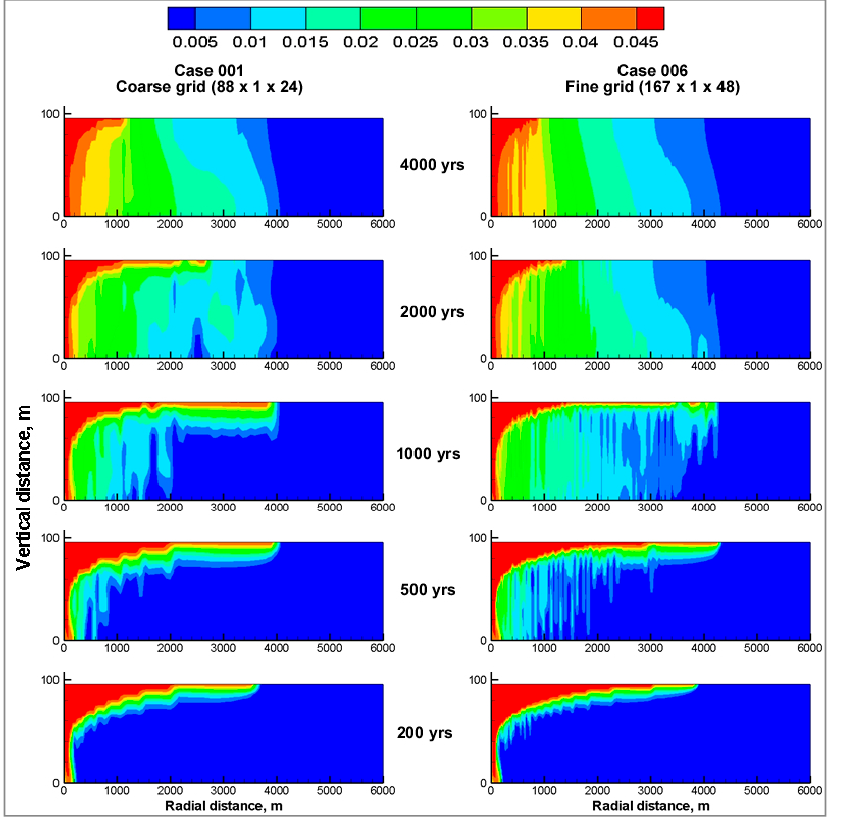
Figure 16. Aqueous CO 2 distribution in coarse and fine ‐ grid homogeneous domains at different time scales.